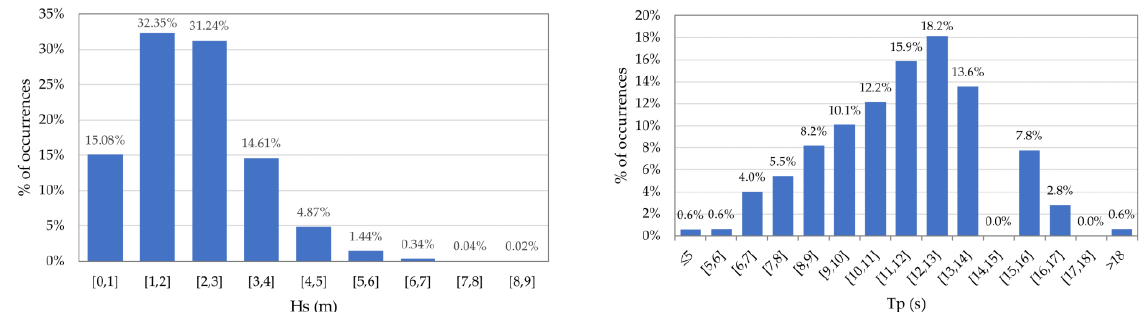
Figure 5. Intervals of H s (left ) and T p ( right ) and the percentage of occurrences.